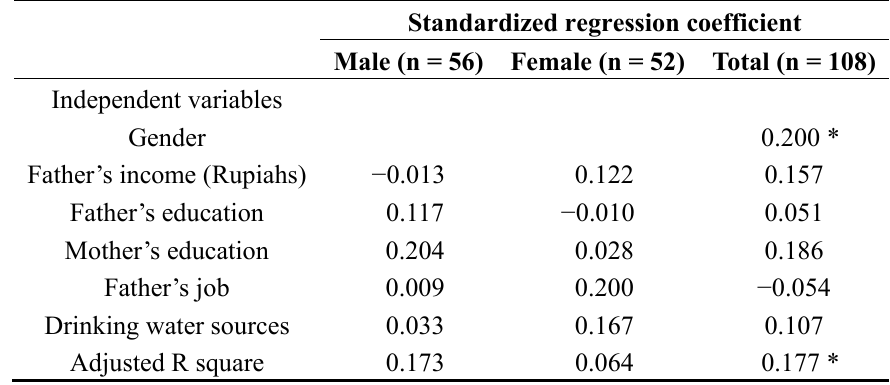
Table 2. Predictors of log BPb among children in Serpong: Multivariate linear regression